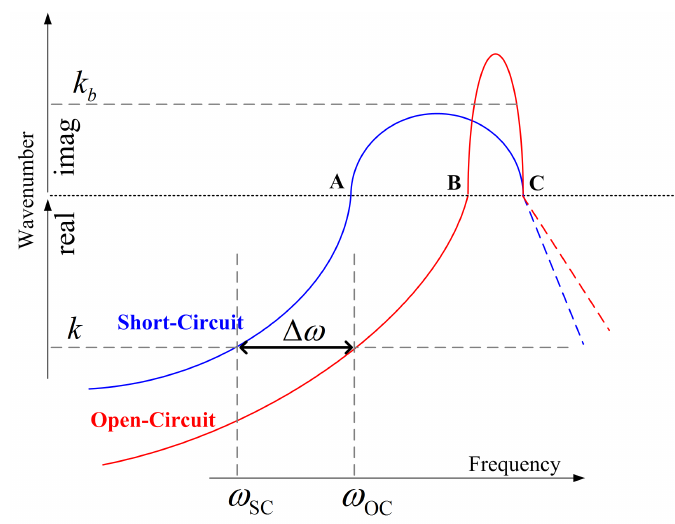
Figure 1. Illustration of dispersion curves for OC and SC status of a piezoelectric